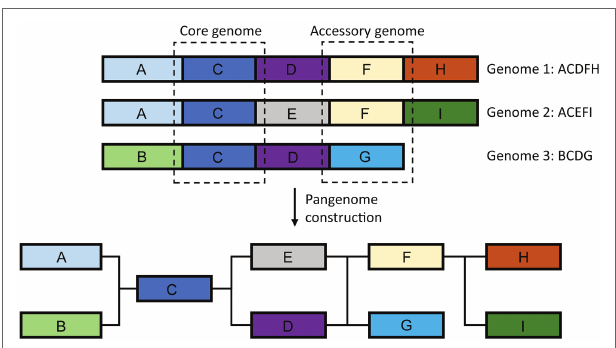
FIGURE 6 | Schematic representation of the plant pangenome. Pangenome represents the entire genomic sequence found in the